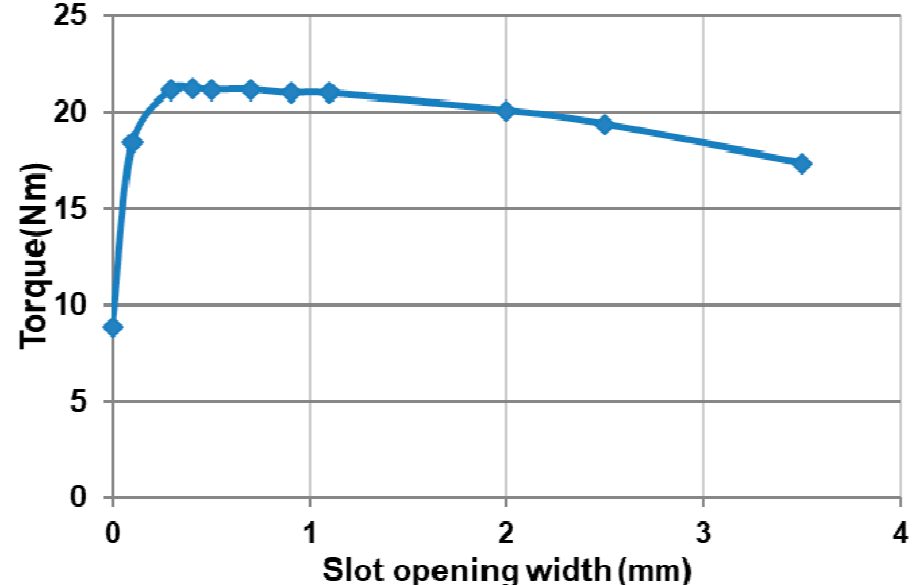
Figure 31. FEA results of the optimization of slot opening width ( O enc ).